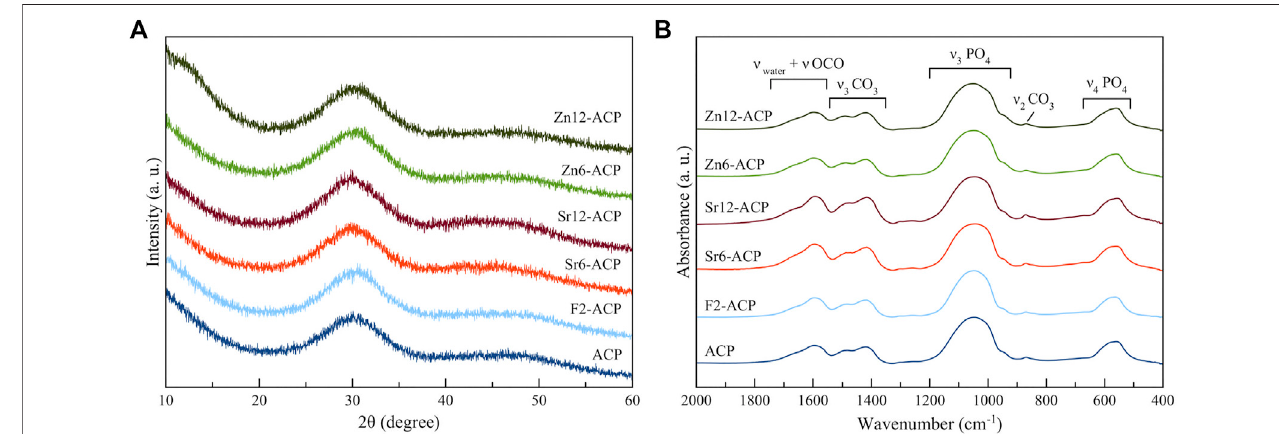
FIGURE 1 | (A) PXRD patterns and (B) FT-IR spectra of ACPs